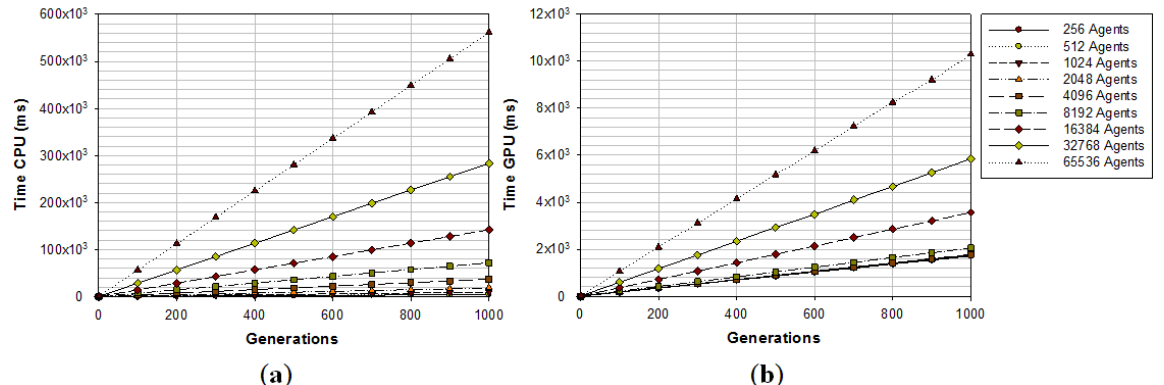
Figure 6. Time consumption of the differential evolution algorithm in a ( a ) parallel CPU and ( b ) a GPU implementation.